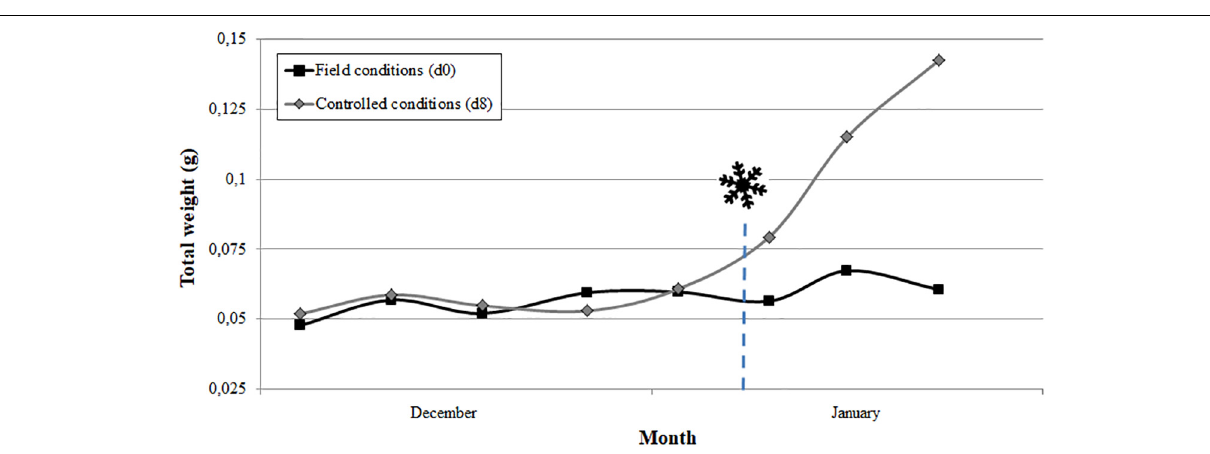
FIGURE 2 | Estimation of breaking of endodormancy date ( (cid:2) ) in the apricot cultivar “Pandora” in 2019 by the Forcing test. Flower bud weight in field conditions and after 8 days in the growth chamber. Chilling requirements were considered fulfilled when the increase in the weight of the flower buds in the growth chamber was 30% higher than in field conditions ( n =